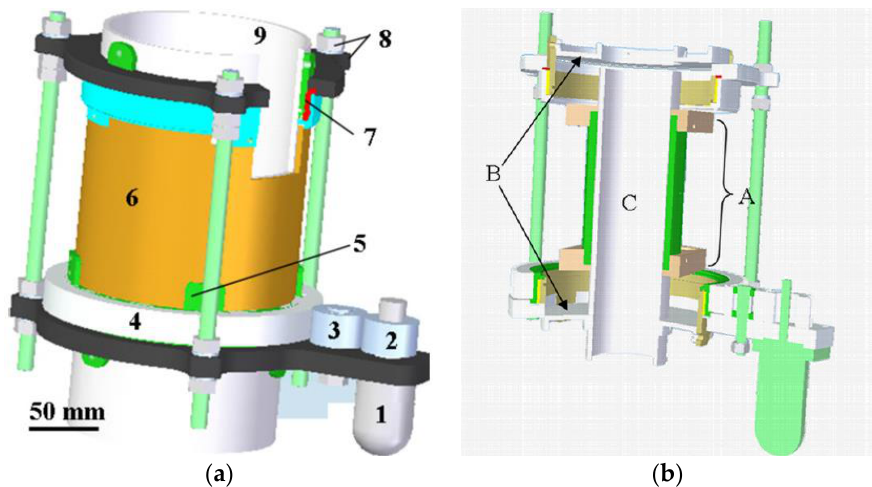
Figure 3. The assembly view of the rotatable sensor: ( a ) 1—stepper motor, 2—driver gear, 3—intermediate gear, 4—transmission gear, 5—supporting mechanism, 6—cylindrical outer tube (electrode holder), 7—sliding bearing, 8—fix mechanism, 9—inner tube (or flow pipe) and the CAD view; ( b ) A—3 parts of the I-shape tube, B—mounting discs, C—flow rig.